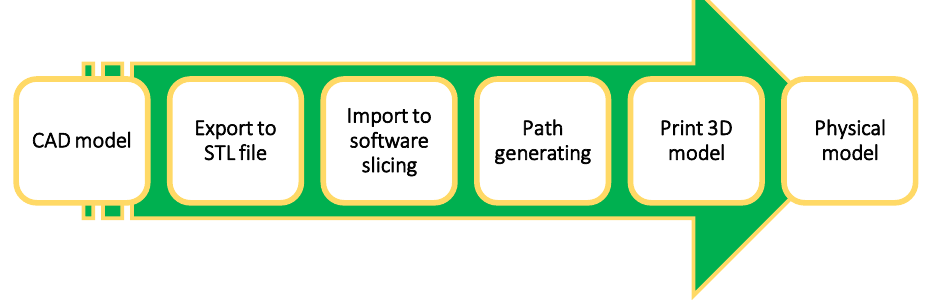
Figure 2. Steps involved in the FDM process to produce 3D printed parts.